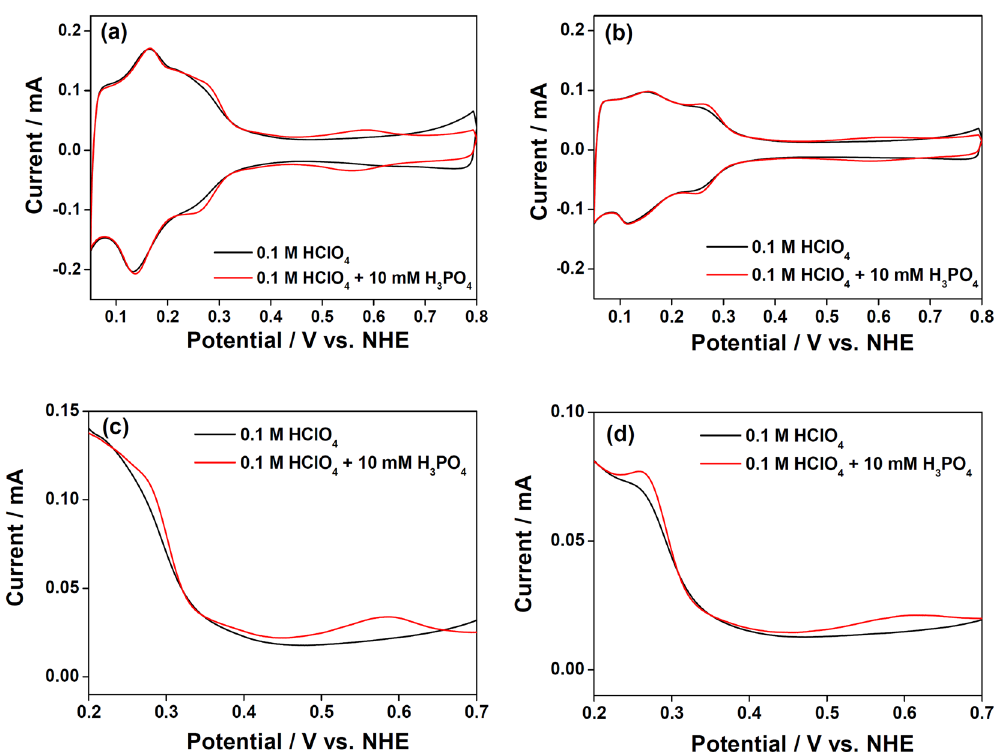
Figure 2. Comparison of cyclic voltammograms of the electrocatalyst with and without phosphoric acid in the electrolyte. ( a ) Pt/C and ( b ) Pt skin /Pt 3 Co/C electrocatalyst in 0.1 M HClO 4 with (red) and without (black) 0.01 M H 3 PO 4 . Magnified anodic sweep of cyclic voltammograms of ( c ) Pt/C and ( d ) Pt skin /Pt 3 Co/C